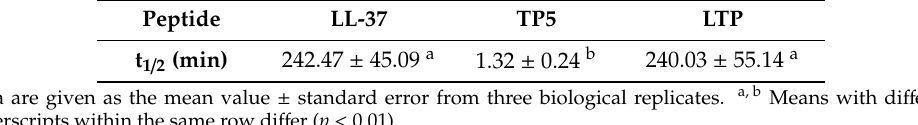
Figure 2. The mean plasma concentrations of LL-37, TP5, and LTP over times. The concentration of each target peptide in plasma in vitro at the selected times was quantified by HPLC. Data are given as the mean value ± standard error from three biological replicates. Table 2. Half-life of LTP in plasma. Peptide